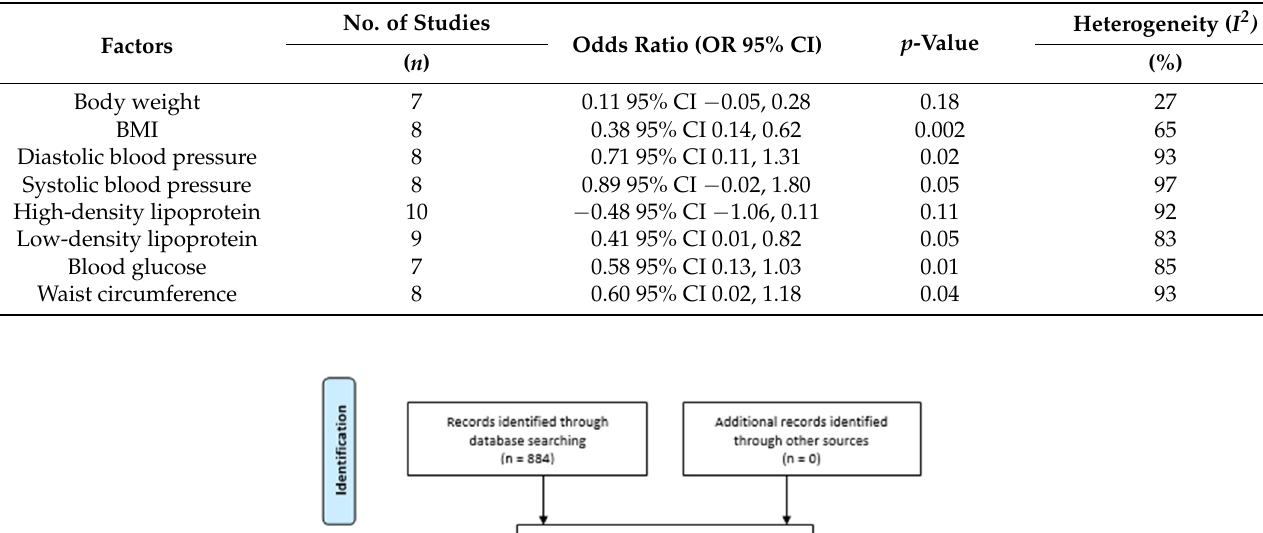
Table 5. Details about the selected factors.